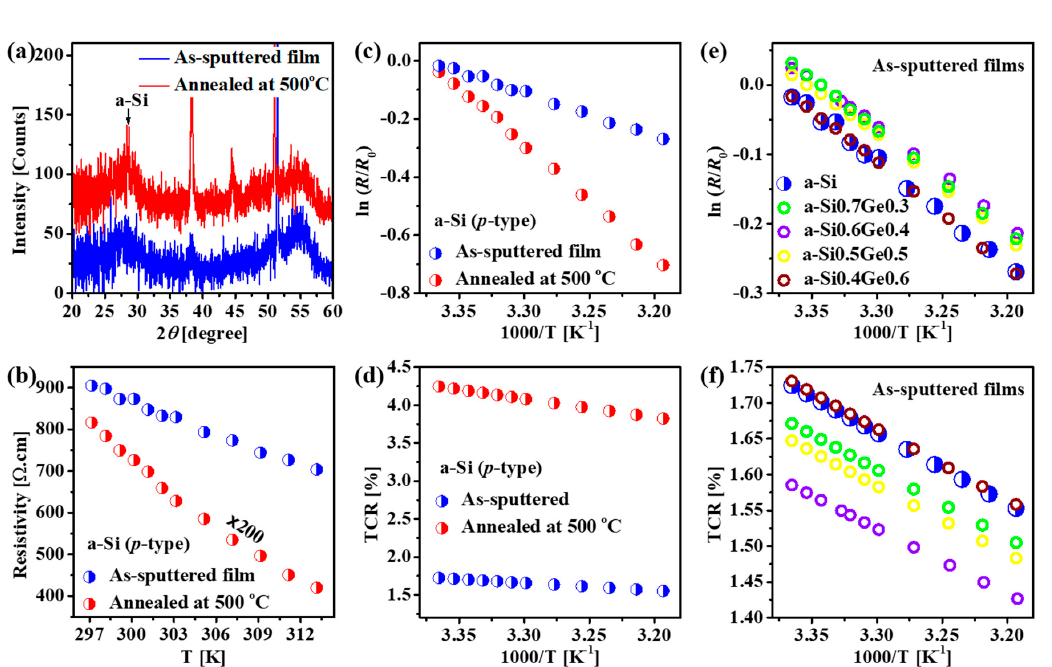
Figure 2. ( a ) XRD patterns and ( b ) Measured temperature-dependent resistivity curves of the as- sputtered (blue curve) and annealed at 500 ◦ C (red curve) a-Si films. ( c ) Natural-log plots represented the change of resistance—ln ( R / R 0 ) and ( d ) TCR values versus temperature changes of the as-sputtered (blue graphs) and annealed at 500 ◦ C (red graphs) a-Si films. ( e ) Natural-log plots ln ( R / R 0 ) and ( f ) TCR values versus temperature changes of a variety of amorphous Si-Ge alloys. where ρ ,